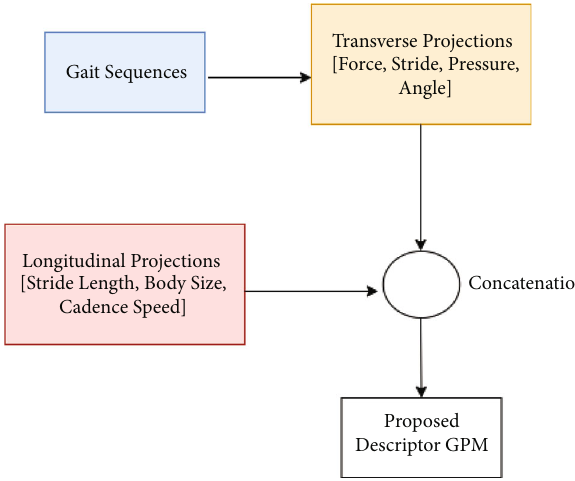
Figure 4: GPM descriptor identi fi cation.